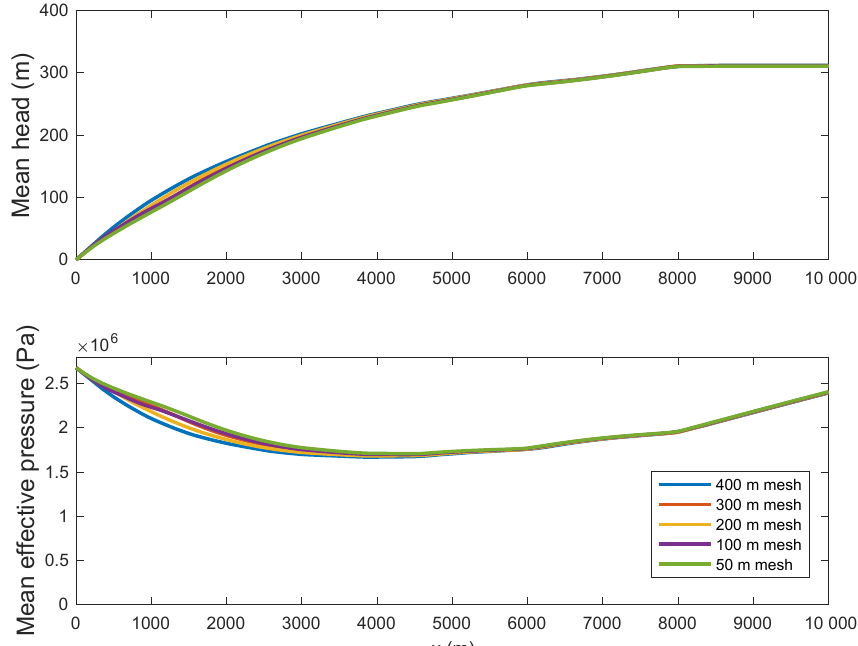
Figure 4. Mean head and effective pressure (averaged in the y direction) for the 10-moulin example (Fig. 3) using unstructured meshes with typical element side lengths ranging from 50 to